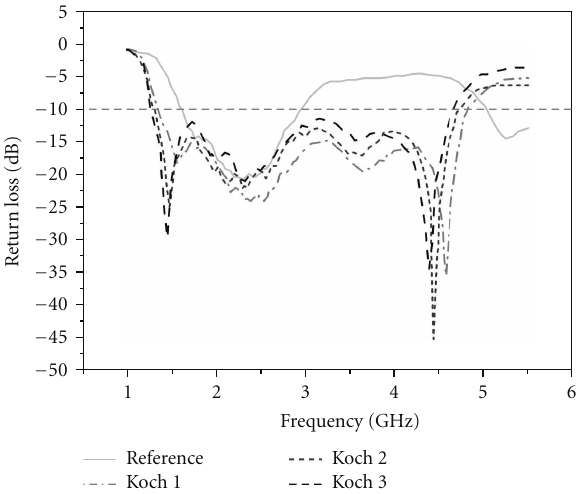
Figure 3: Comparison of the measured return loss.